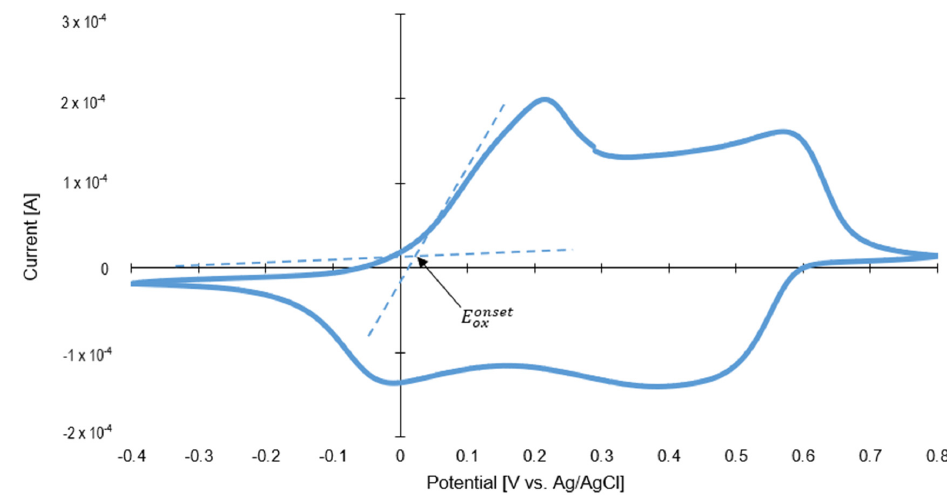
Figure 7. Cyclic voltammograms of polyaniline.